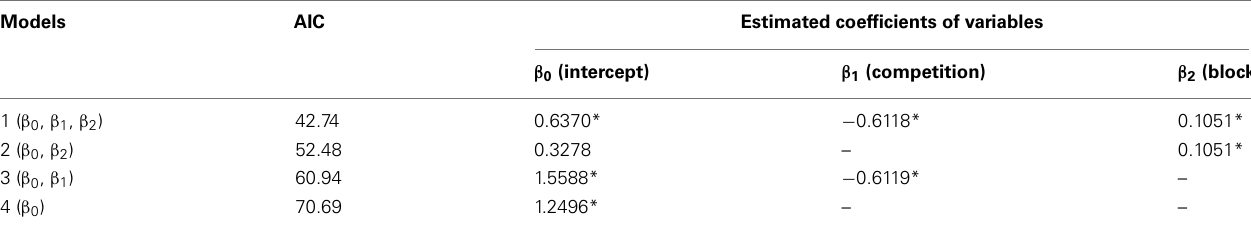
TableA4 | Delay to LL (data shown in Figure 2B) was analyzed by generalized linear mixed model (GLMM). Models